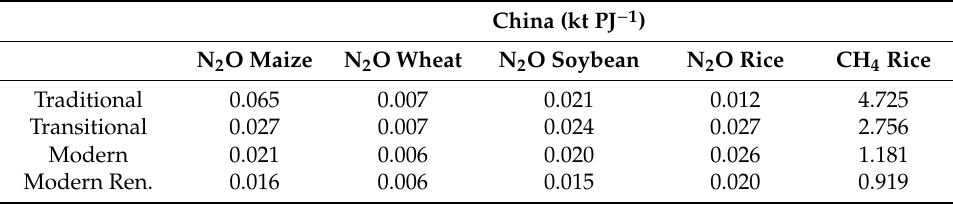
Table 7. Nitrous Oxide and Methane emissions per mechanisation for